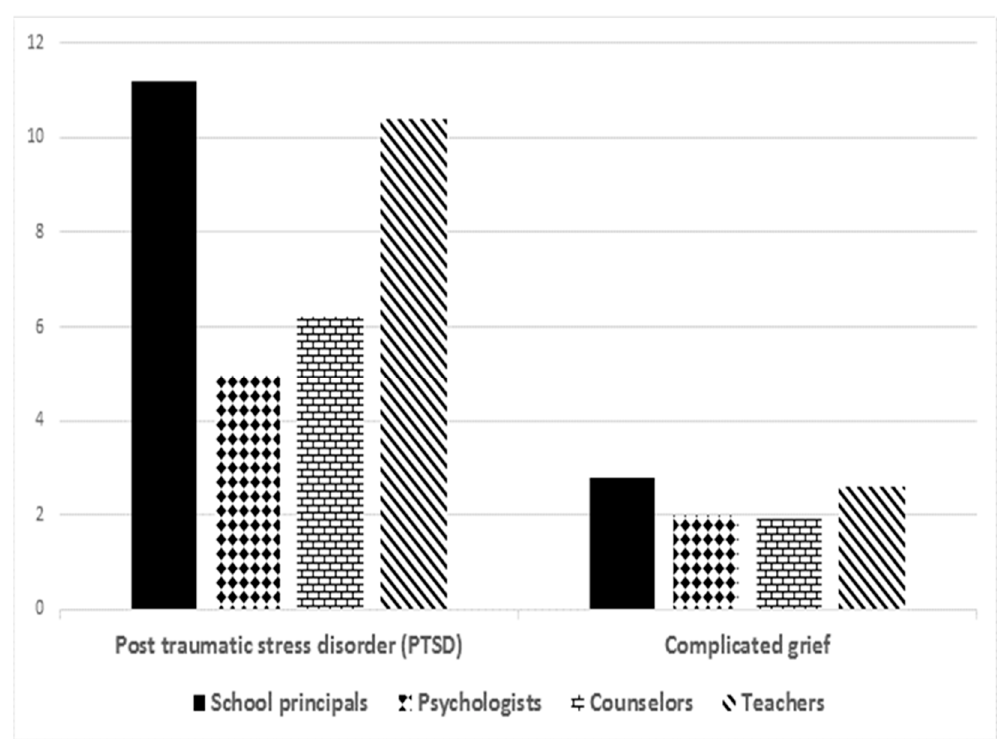
Figure 1. Differences between the domains regarding the intensity of complicated grief and post- traumatic stress disorder (PTSD). The scales of the measures were adjusted so that it would be possible to put them on the same graph in relation to each other. p < 0.01.